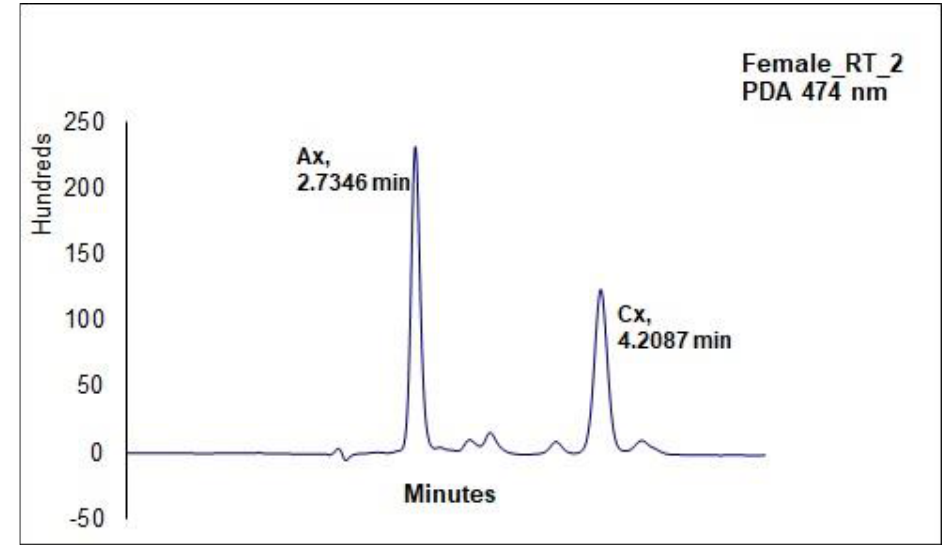
Figure 2. Typical chromatogram of sample solution of female gonads.